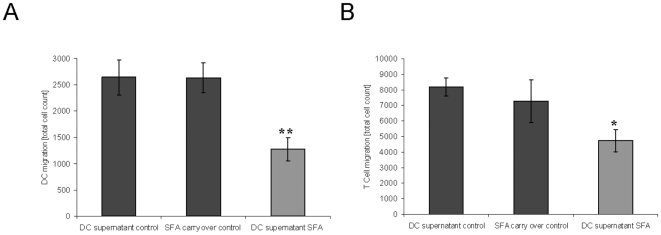
Supernatant of SFA-exposed moDC induces reduced migration of activated moDC and CD4+ T cells.moDCs were generated in the presence of GM-CSF and IL-4 and activated for 12 h with LPS. CD4 T cells were isolated by microbead-sorting and activated for 16 h with CD3/CD28 mAbs. DC supernatant from SFA- or vehicle-exposed moDCs was harvested 12 h after LPS activation and added to the lower chamber of the transwell. The “SFA carry over control” consisted of supernatant of control-treated moDCs+1 µM SFA. Migration of cells was quantitated by flow cytometry. (A) Activated moDCs were inserted in the upper chamber of the transwell and migration was analysed after 4 h. (B) Activated CD4+-T cells were set in the upper chamber of the transwell and migration was analysed after 4 h. The spontaneous migration of cells was subtracted from the results (mean DCs: 1673; T cells: 8676). The results are representative for n = 9 (A) and n = 5 (B) independent experiments. Mean (± SEM) **p<0.01, *p<0.05 versus vehicle.